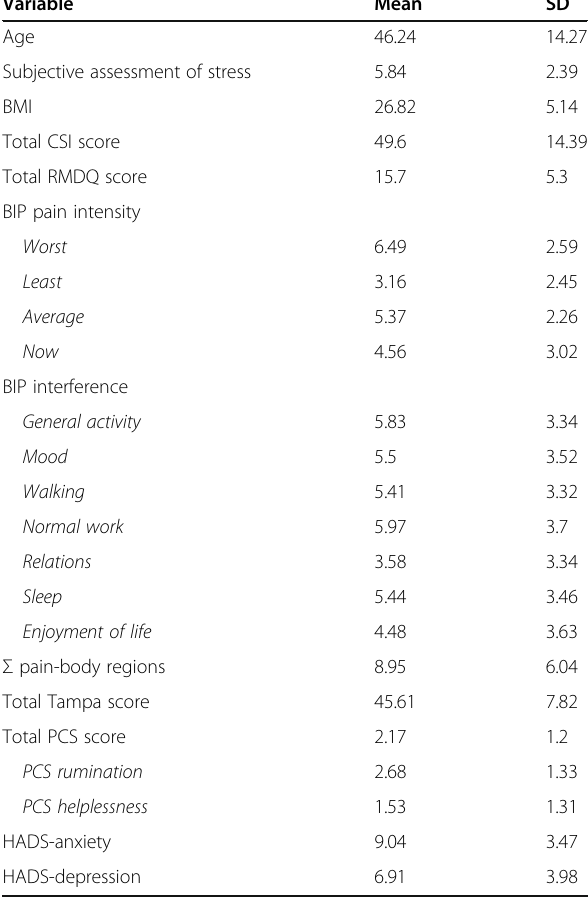
Table 1 Characteristics of the sample studied Variable